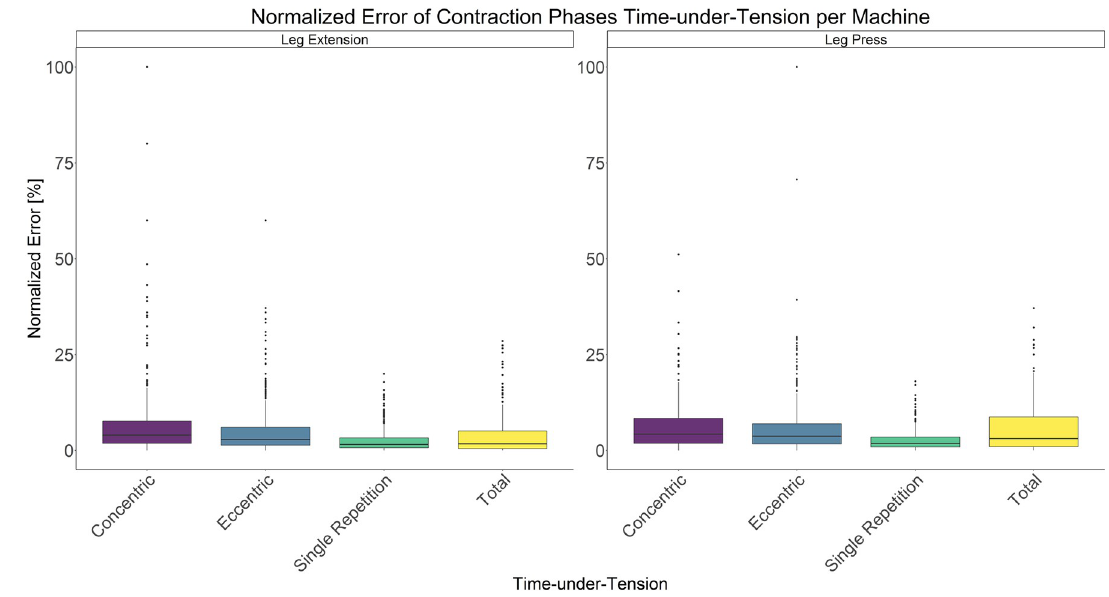
Fig 19. Boxplot of normalized errors of contraction-specific phases for both resistance exercise machines.